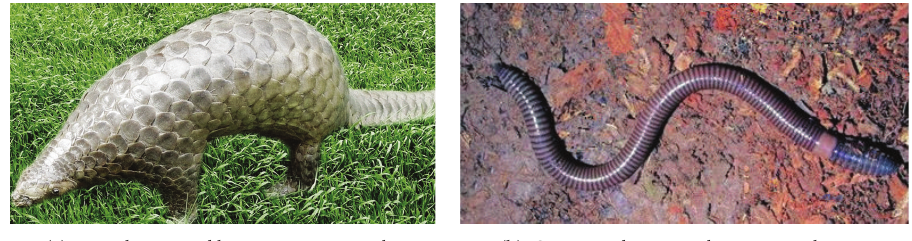
Figure 1: Nonsmooth surface of creatures.